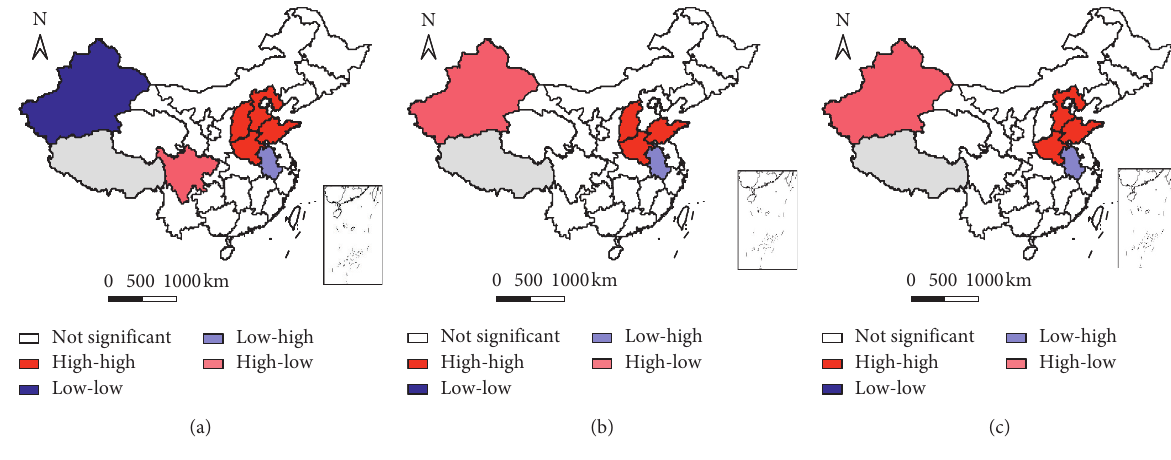
Figure 3: Lisa cluster maps of environmental pollution in Table 3: Traditional panel model estimation results of FDI, regional corruption, and environmental pollution.